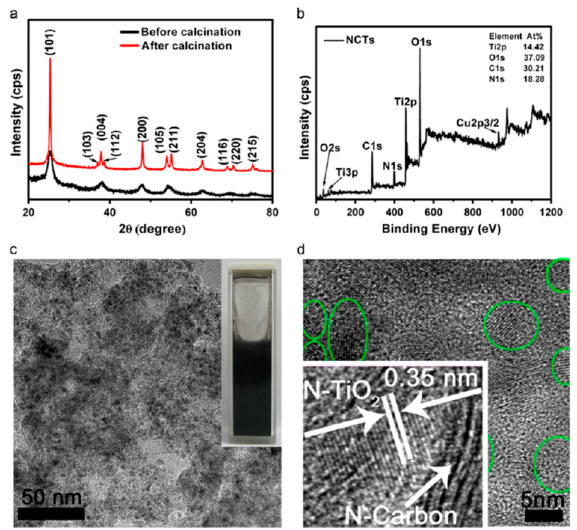
Figure 5. ( a ) XRD patterns and ( b ) XPS full spectrum of N-doping carbon–TiO 2 nanohybrids. ( c ) TEM image. Inset: digital image of N-doping carbon–TiO 2 nanohybrids solution. ( d ) HR-TEM image. Inset: HR-TEM image of single N–TiO 2 on N doped C film (N–Carbon). From Ref. [58]. Reprinted with permission from Elsevier.